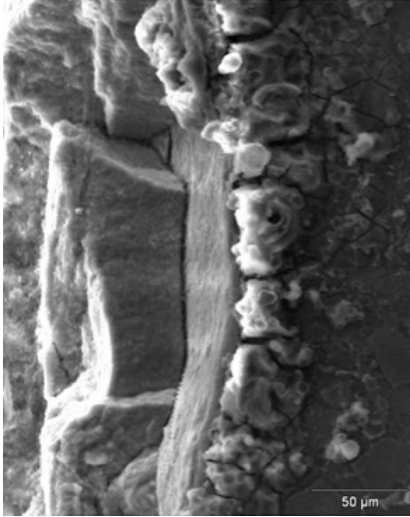
Figure 13: SEM analysis. Section view of the pit. Corrosive process. – 600 X. Scale